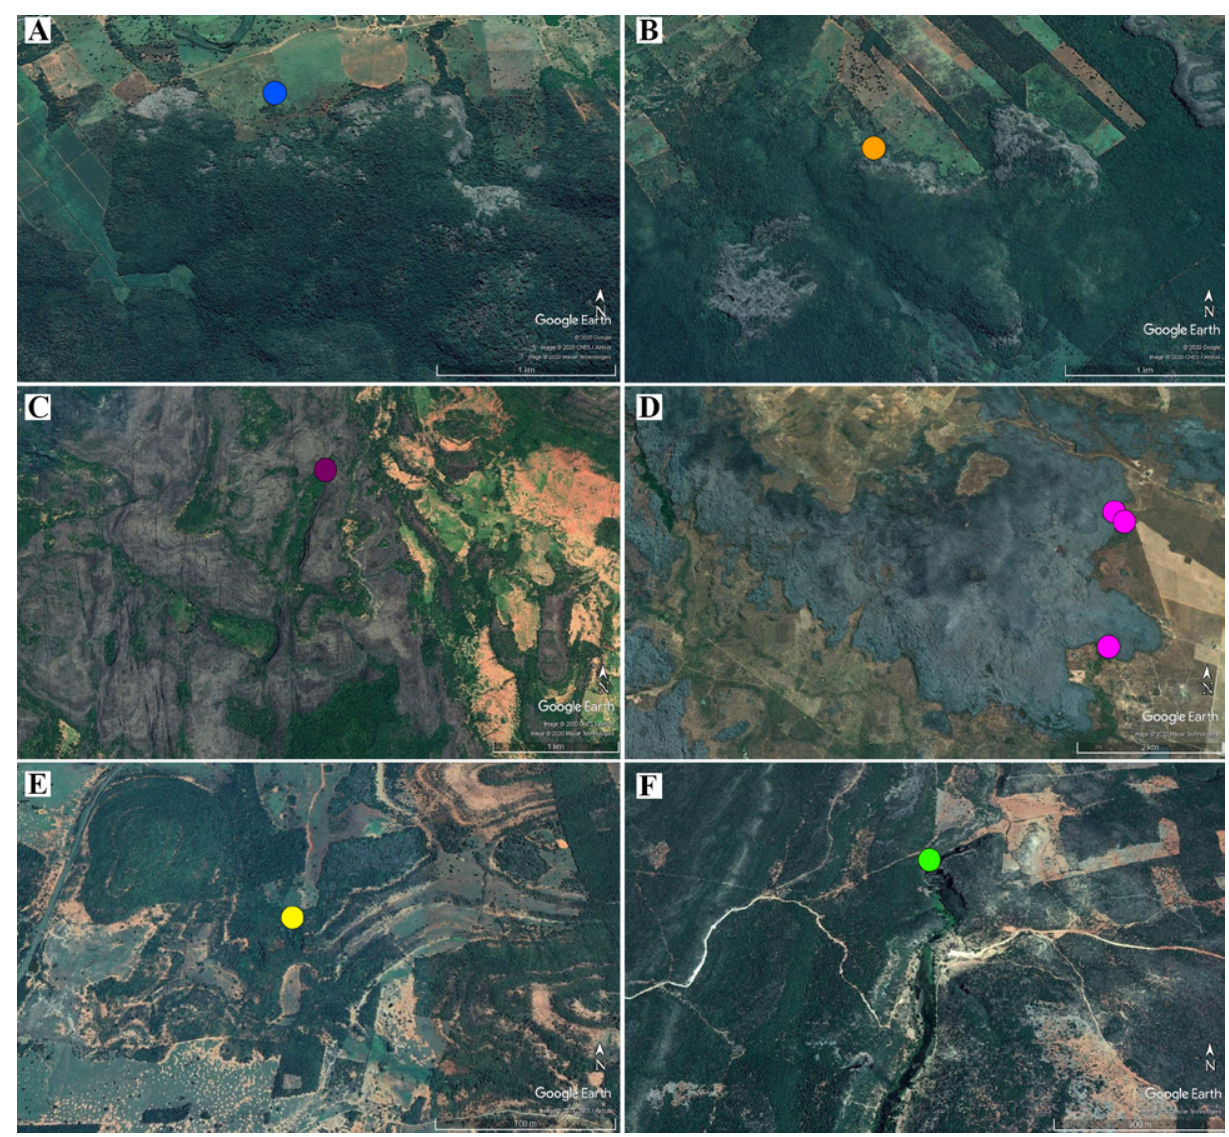
Figure 22. Satellite images of localities: A , Abrigo da Ema (Montalvânia municipality); B , Gruta do Tabuleirinho (Juvenilia municipality); C , Baixa da Fortuna cave (Iuiu municipality); D , Gruna da Água Clara Cave, Gruna dos Índios cave and Gruna dos Peixes II, from top to bottom (Carinhanha municipality); E , Gruta do Padre cave (Santana municipality); F , Gruta dos Brejões (Morro do Chapéu